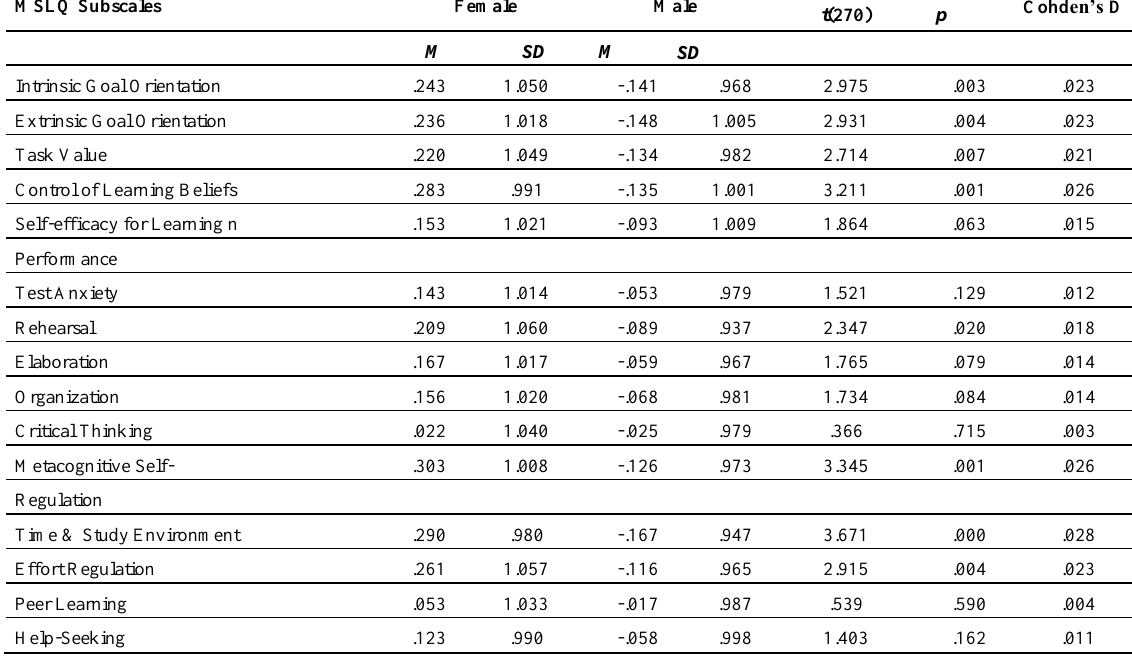
Table.6. Gender effect on the MSLQ (subscales) with effect